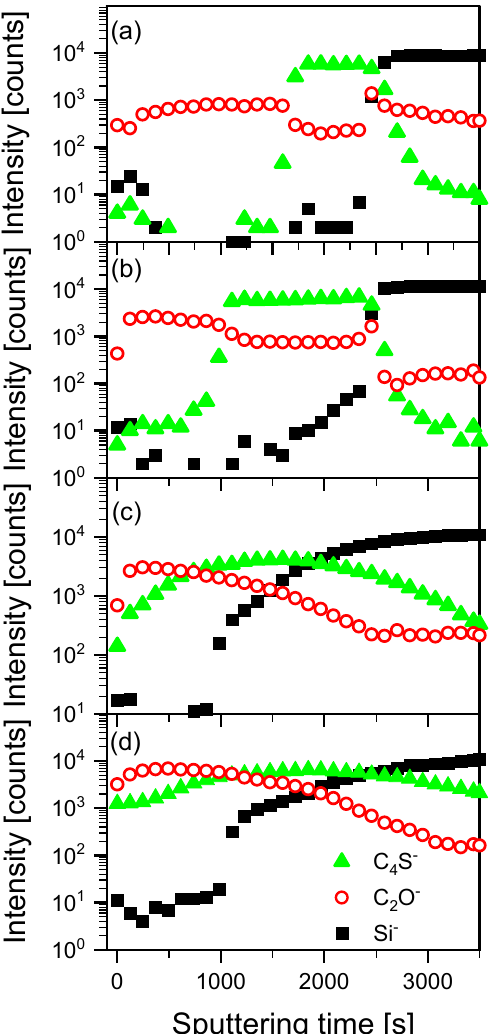
Figure 4. SIMS depth profiles of PC 60 BM/PCDTBT bilayers: ( a ) as-prepared or exposed to chloroform vapor for ( b ) 30 min, ( c ) 45 min and ( d ) 60 min.